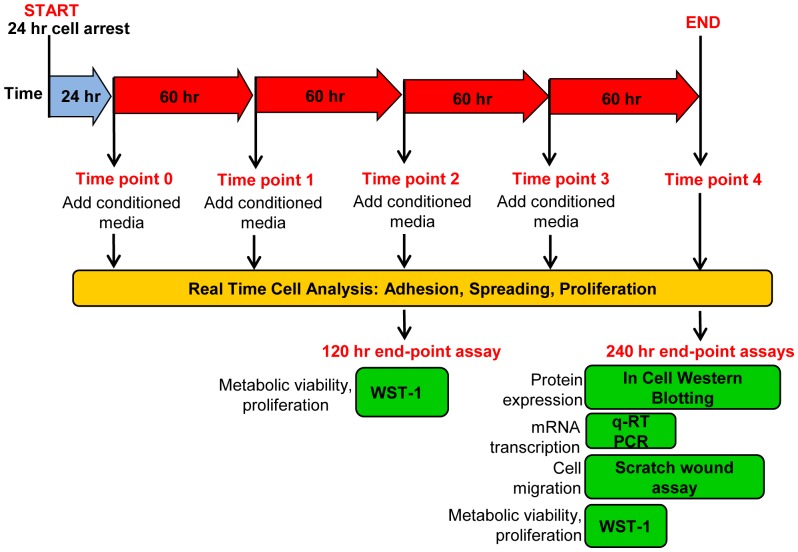
Schematic timeline for treatment of primary culture cells with conditioned media.NF (n = 4), NS (n = 4), PKF (n = 5), and IKF (n = 5) were independently treated with all the different conditioned media types (n = 16) following 24 hrs cell synchronisation. Conditioned media was continually replaced every 60 hrs up to a final treatment period of 240 hrs. RTCA on a micro-sensory array was undertaken for the complete 240 hrs whereas end-point assays were conducted at either 120 hrs or 240 hrs. PKF = peri-lesional keloid fibroblasts, IKF = intra-lesional keloid fibroblasts, NF = normal dermal fibroblasts, NS = normal dermal scar fibroblasts, RTCA = Real time cell analysis.